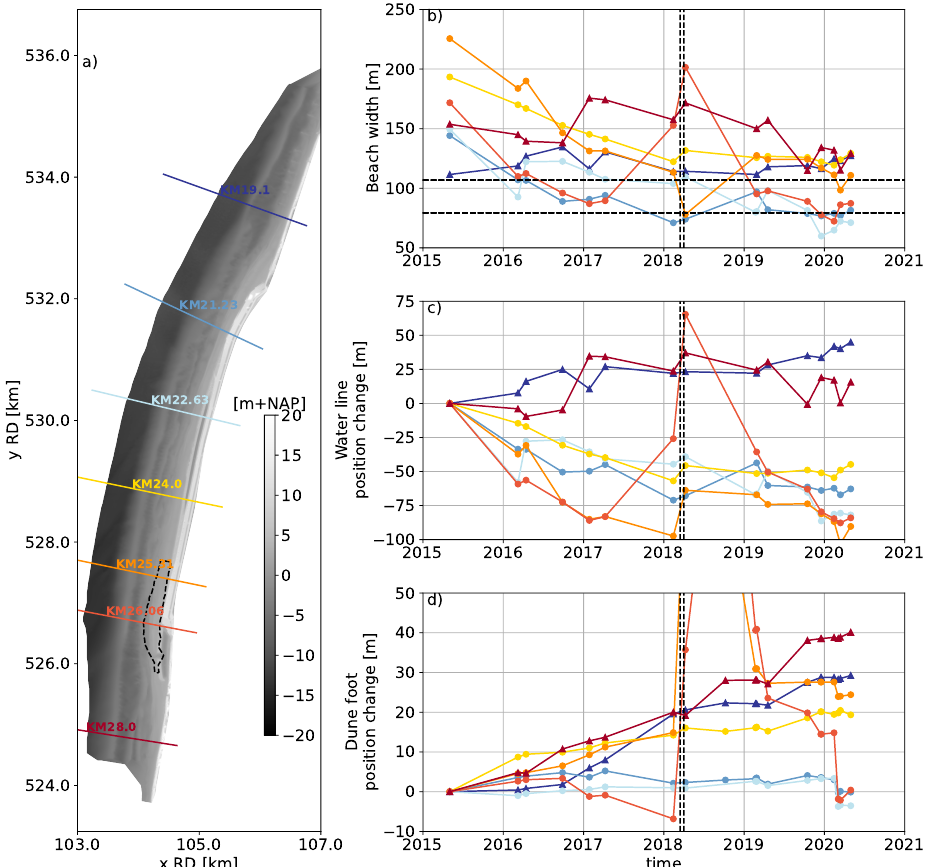
Figure 12. Beach width in time for transects 19.1, 21.23, 22.63, 24, 25.31, 26.06, and 28. ( a ) Location of transects. ( b ) Beach width. ( c ) Waterline position change. ( d ) Dune foot position change. The black dotted horizontal lines indicate the µ ± σ beach width at the adjacent coast. The black dotted vertical lines indicate the period of the additional 2018 beach nourishment. Eroding and accretive transects are marked with circle and triangle symbols,